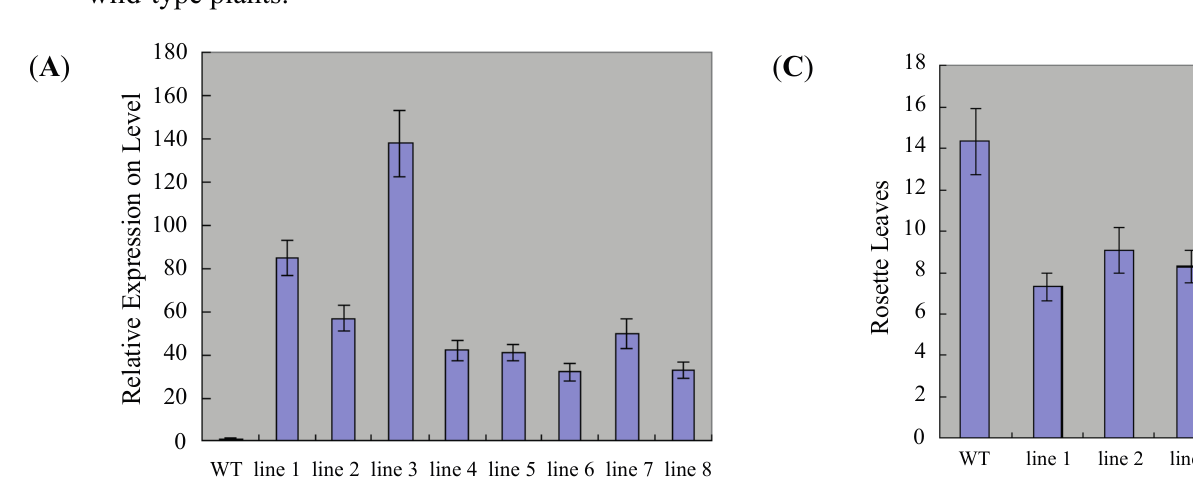
Figure 4. Overexpression of ZmSOC1 promotes flowering in Arabidopsis . ( A ) ZmSOC1 expression in transgenic plants. The expression level of AtActin2 was used as an internal references. Values represent the means, and the error bars represent standard errors for three independent experiments; ( B ) The phenotype of ZmSOC1 transgenic lines under the LD (Long-day) condition (14/10 h light/dark, 22 °C) after 30 days ( above ) and 40 days ( below ); ( C ) The number of rosette leaves during flowering in transgenic plants and wild-type